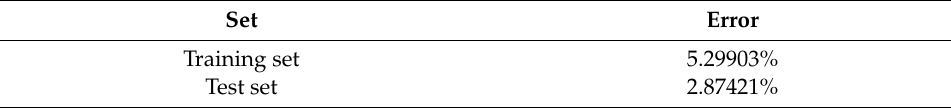
Table 2. Errors of hole size prediction.